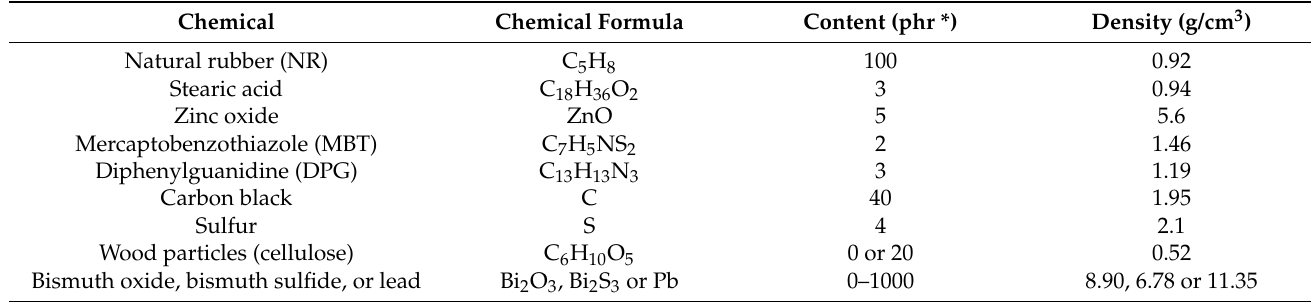
Table 1. Name, chemical formula, content, and density of chemicals used for the simulation in this work [14,20]. Chemical Chemical Formula Natural rubber